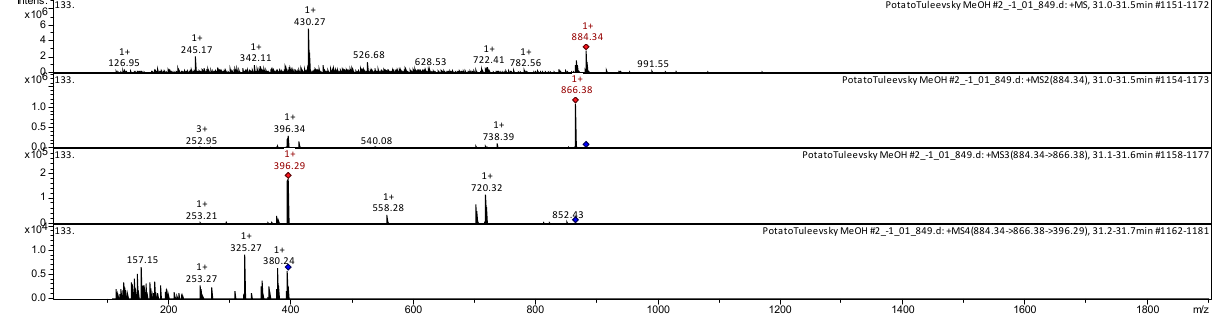
Figure 7. CID-spectrum of Leptinine II from extracts of S. tuberosum (variety Tuleevsky), m / z 884.34.